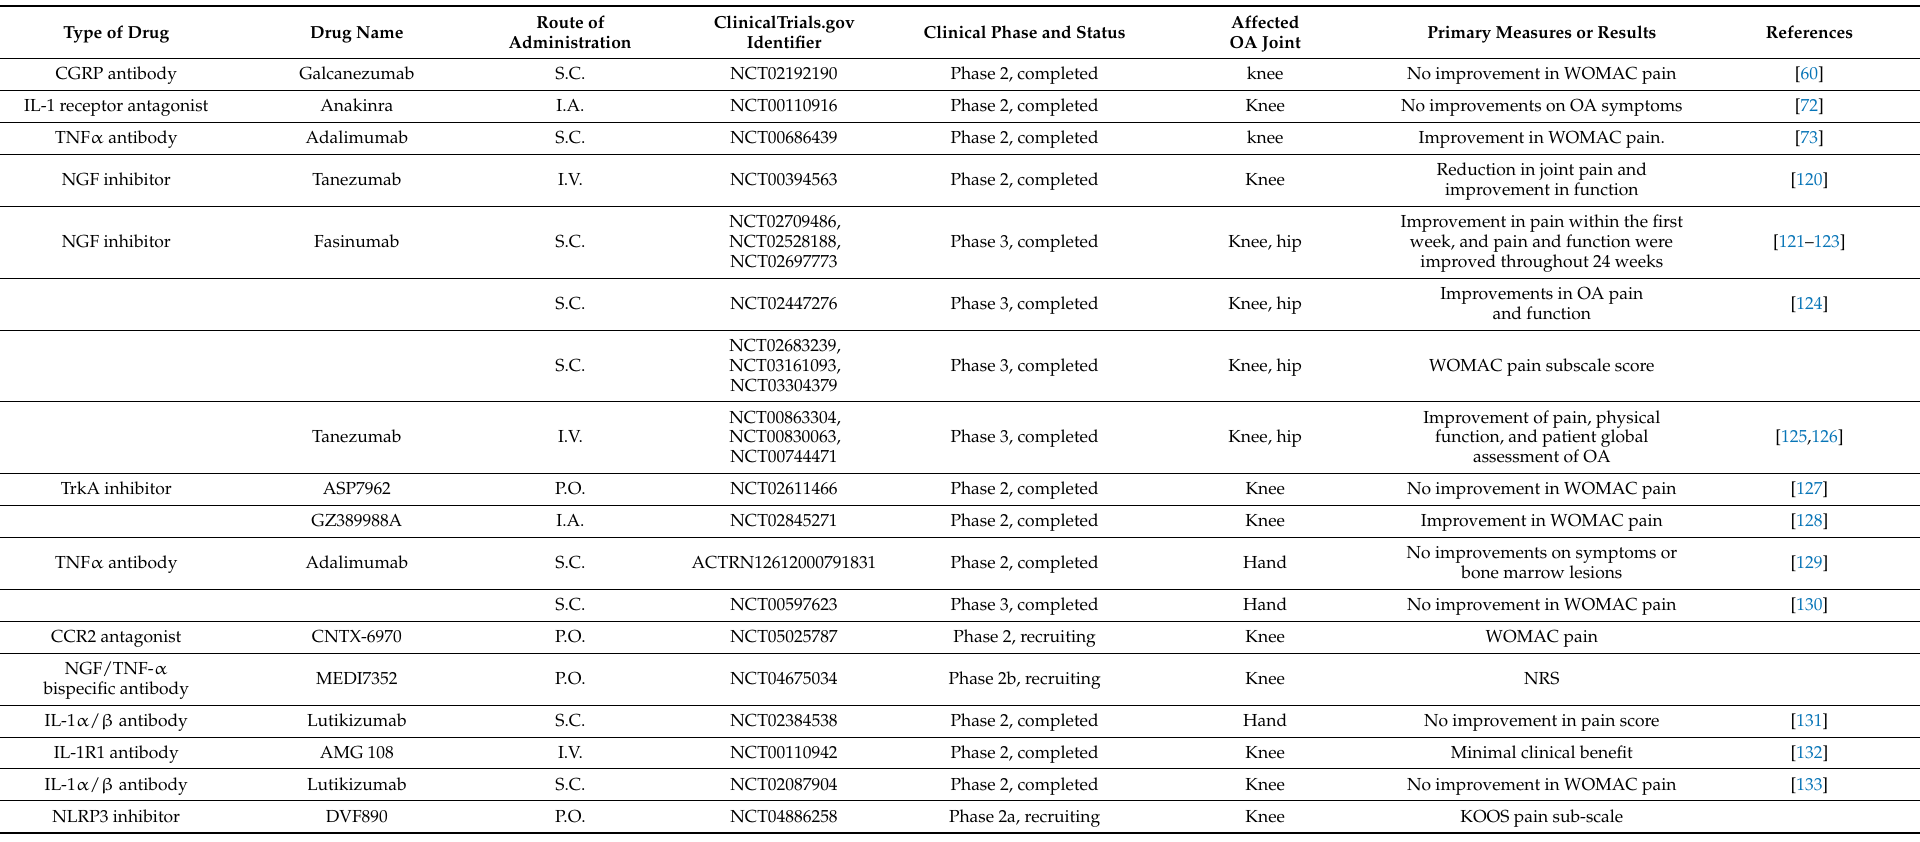
Table 2. Summary of new pharmacological therapies for OA pain in clinical